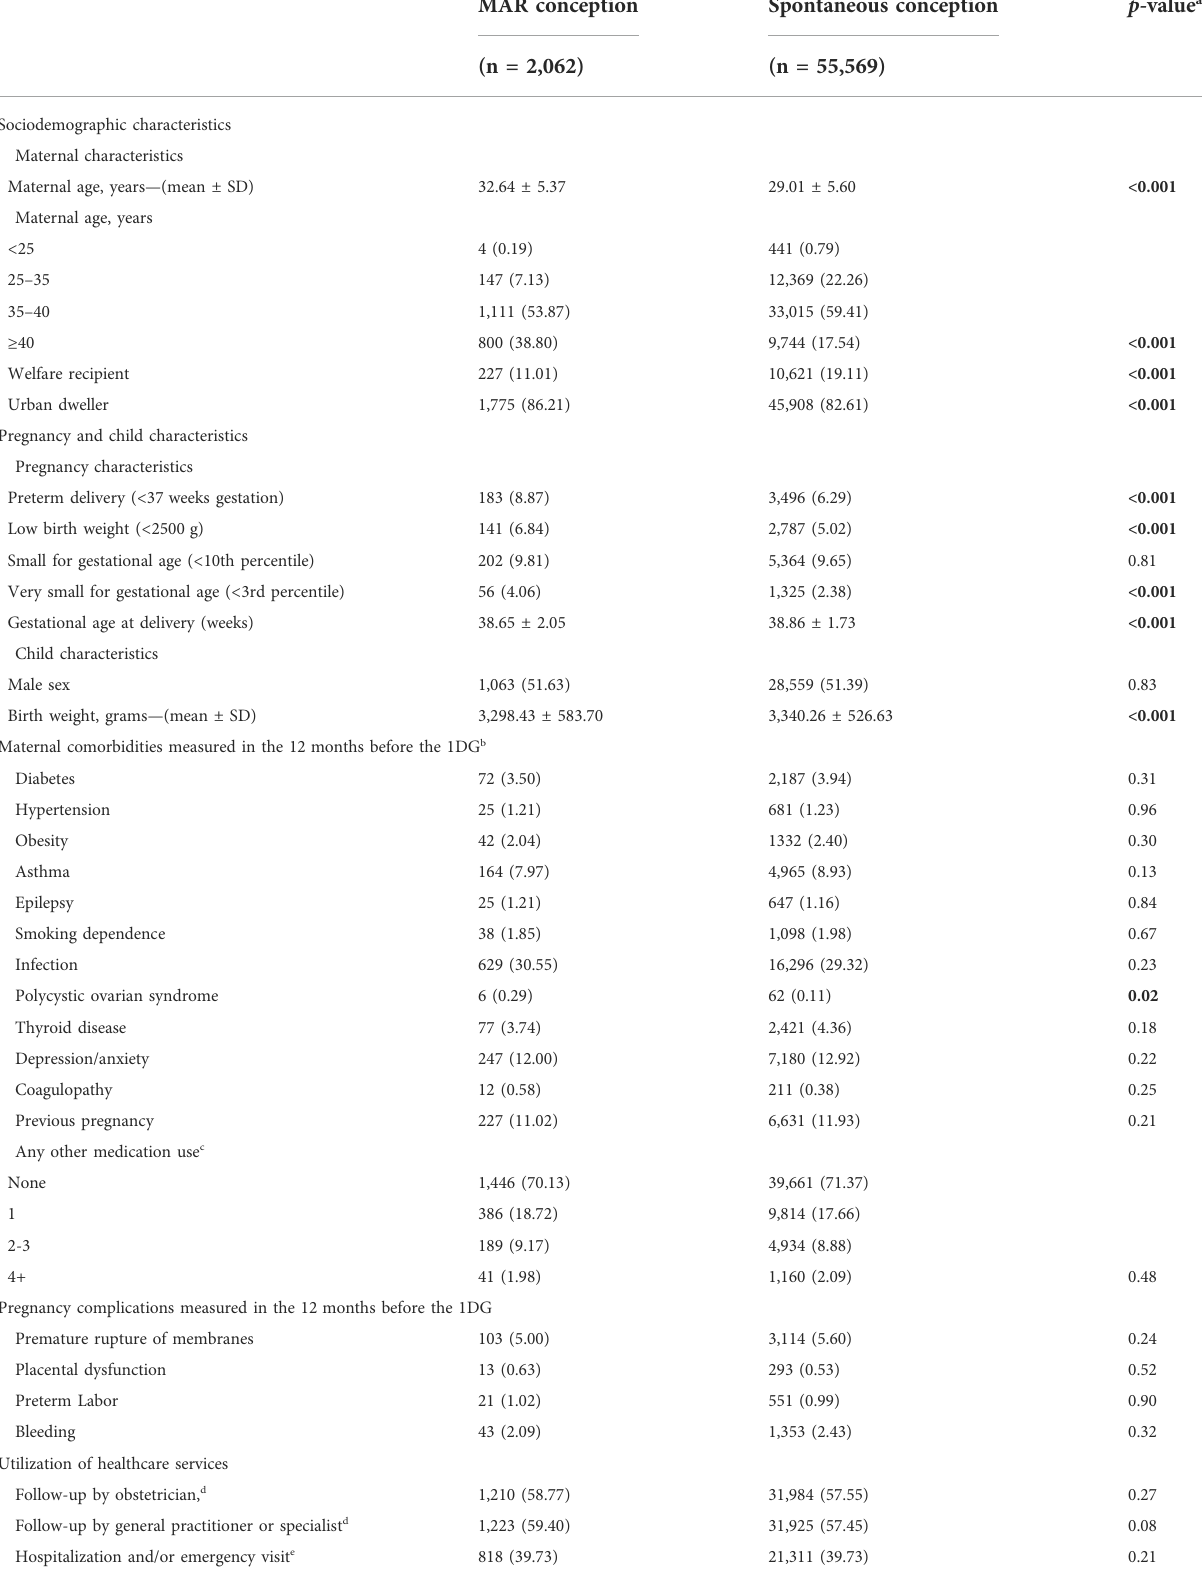
MAR conception Spontaneous